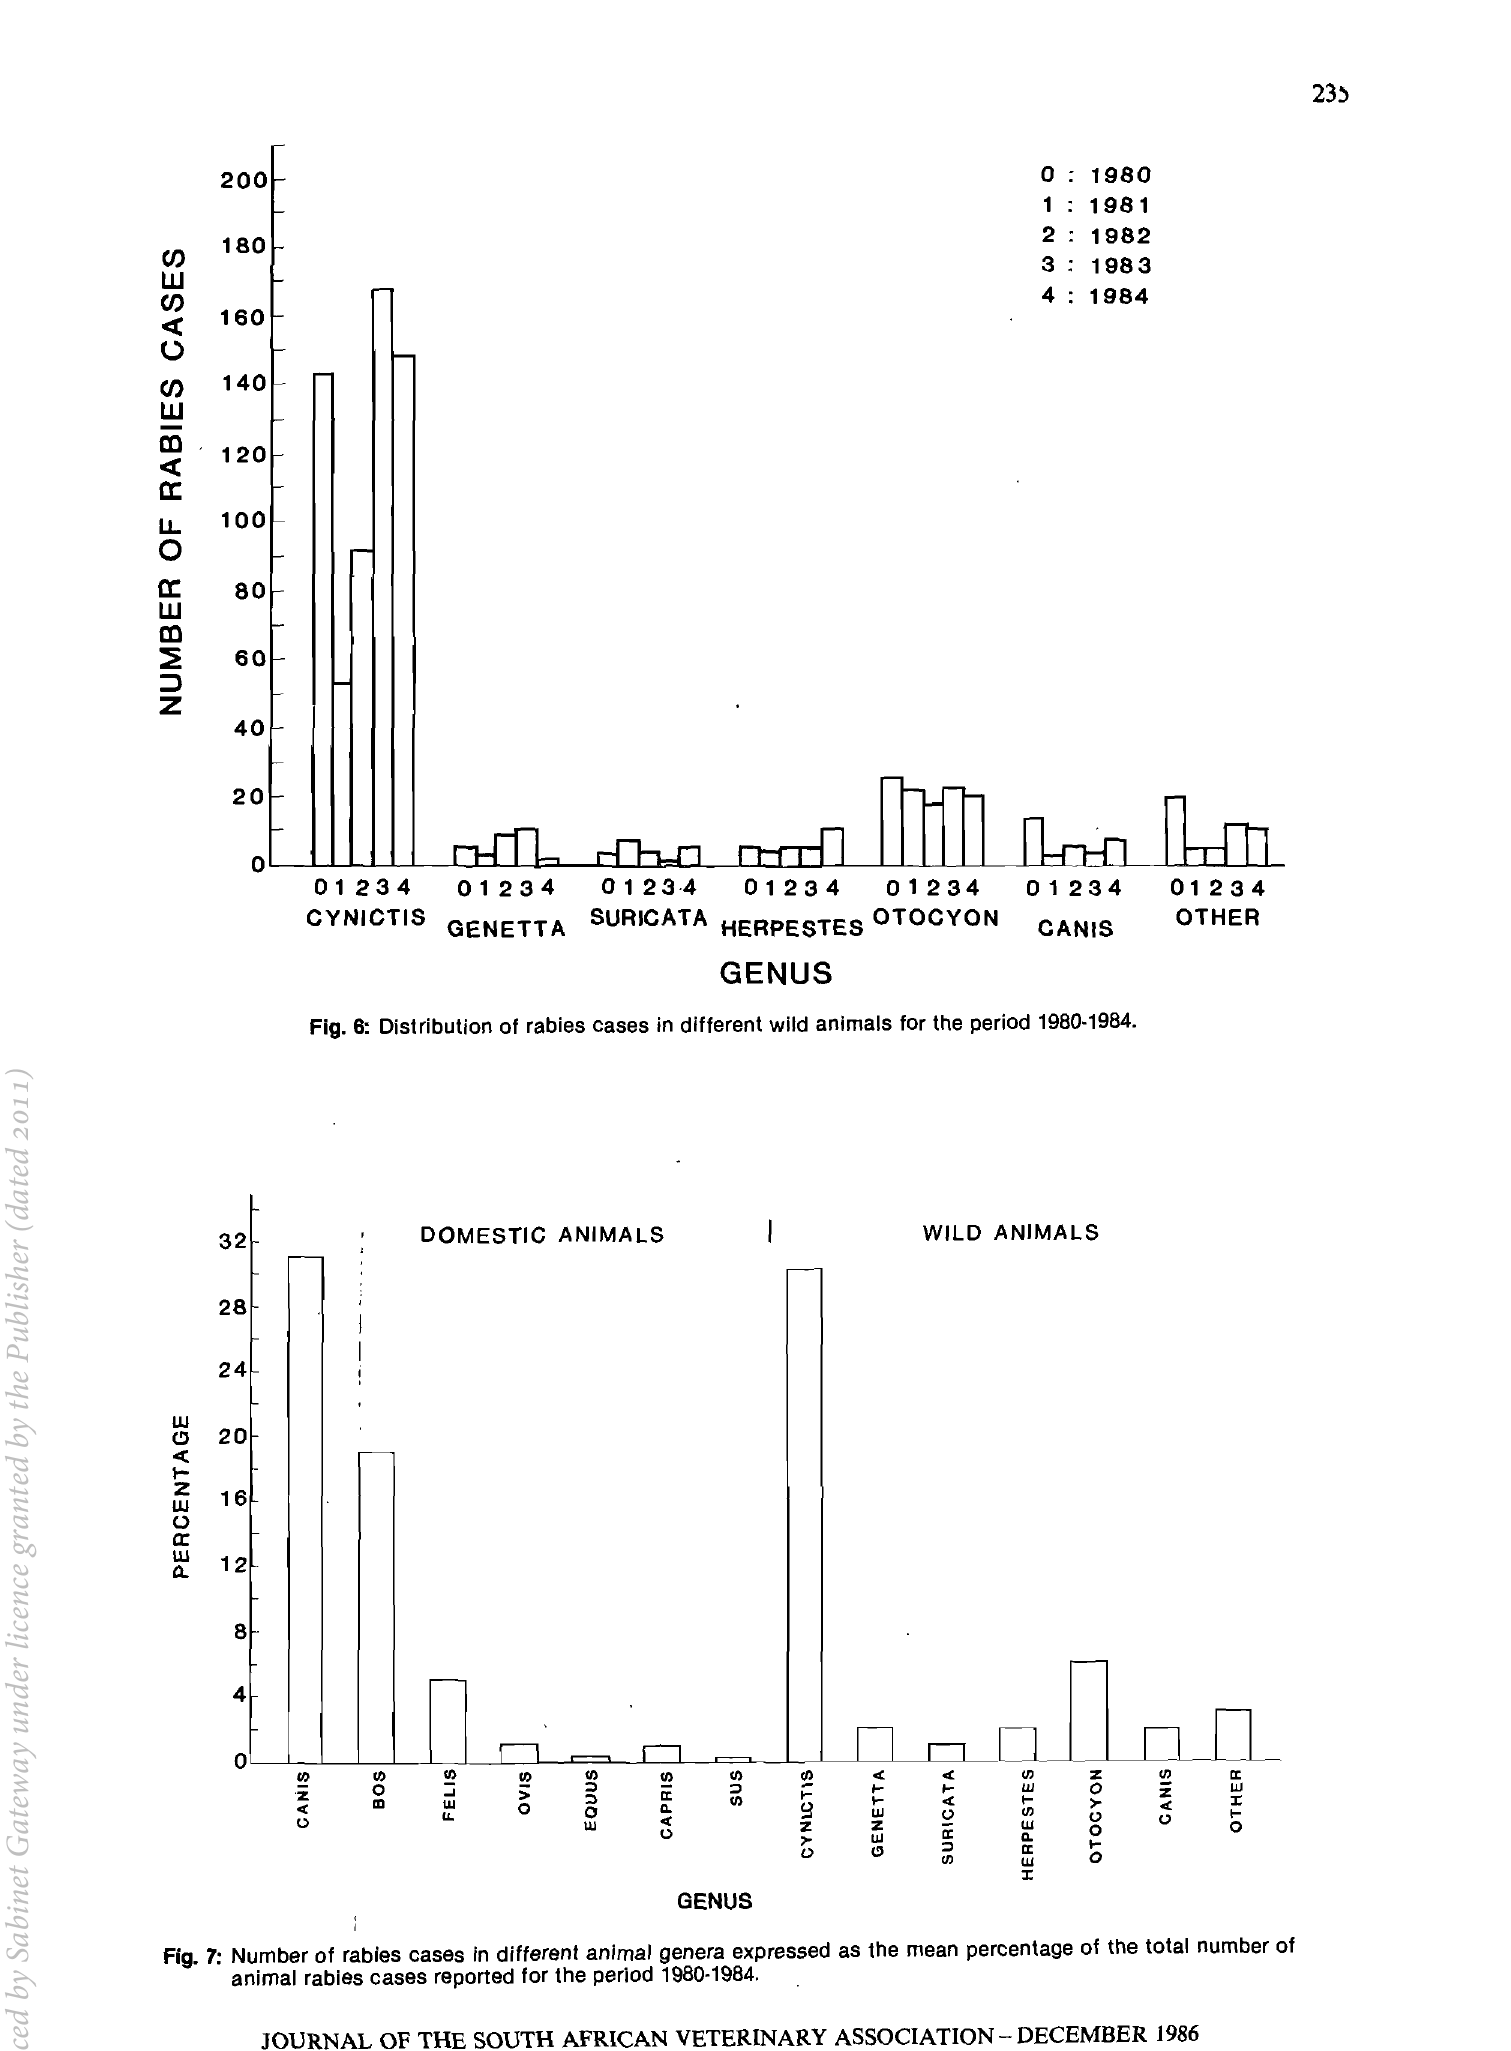
Fig. 7: Number of rabies cases in different animal genera expressed as the mean percentage of the total number of animal rabies cases reported for the period 1980-1984. JOURNAL OF THE SOUTH AFRICAN VETERINARY ASSOCIATION - DECEMBER